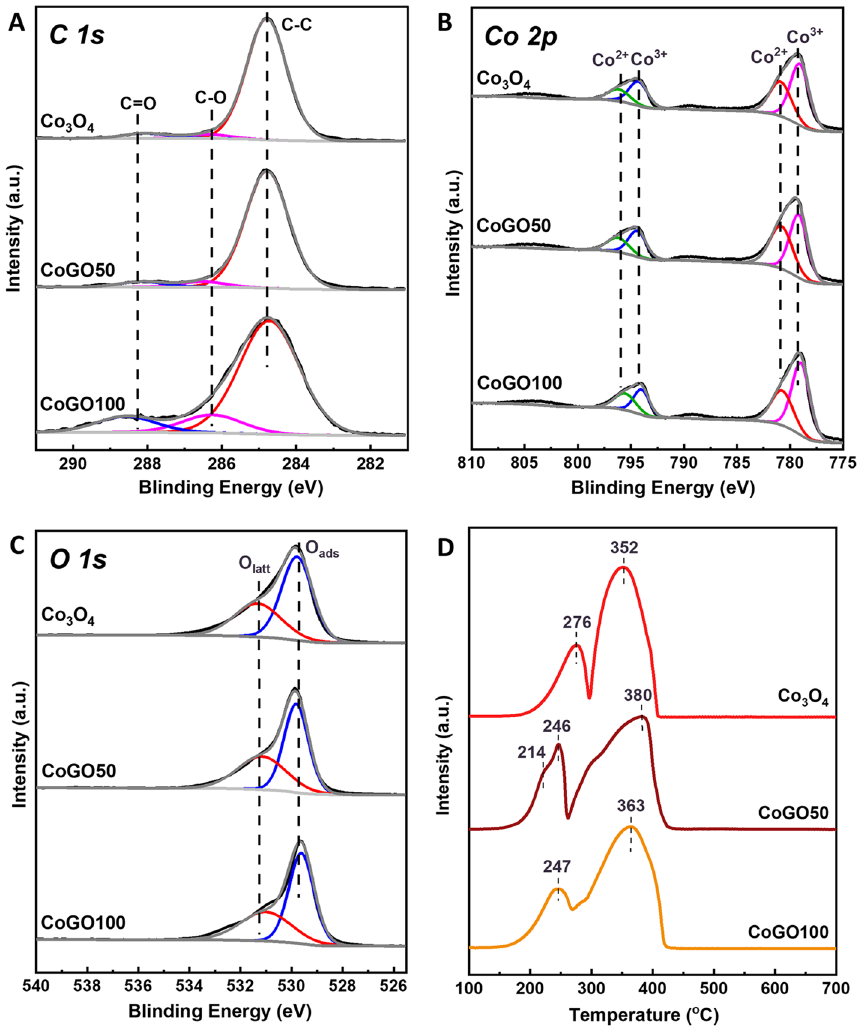
Figure 4. XPS C 1s ( A ), Co 2p ( B ) and O 1 s ( C ) spectra and H 2 -TPR profiles ( D ) of Co 3 O 4 , CoGO50 and CoGO100.